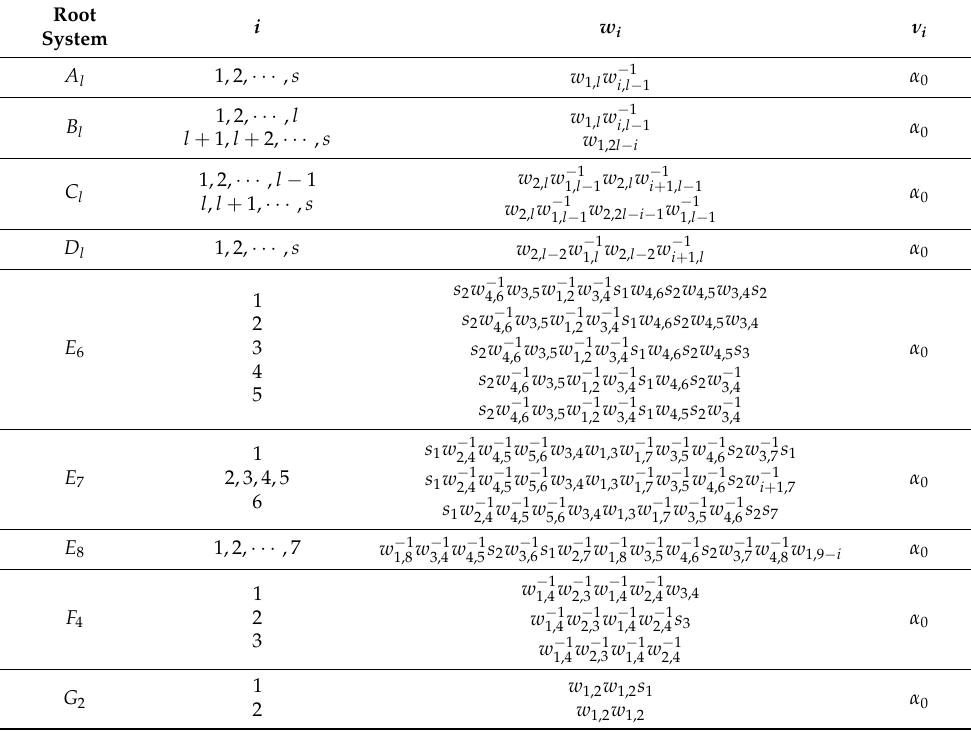
Table 2. Descriptions of w i and ν i